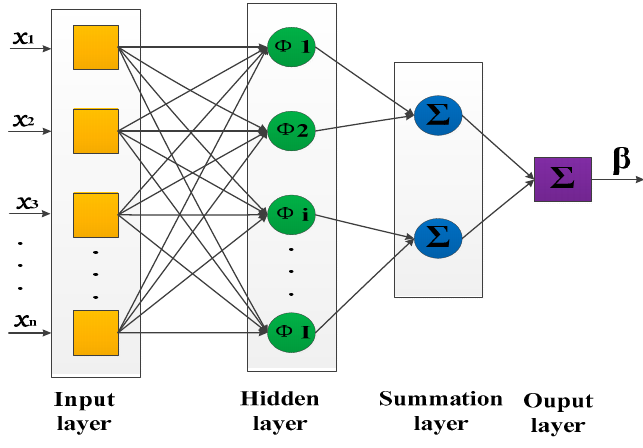
Figure 2. Structure of typical PNN.